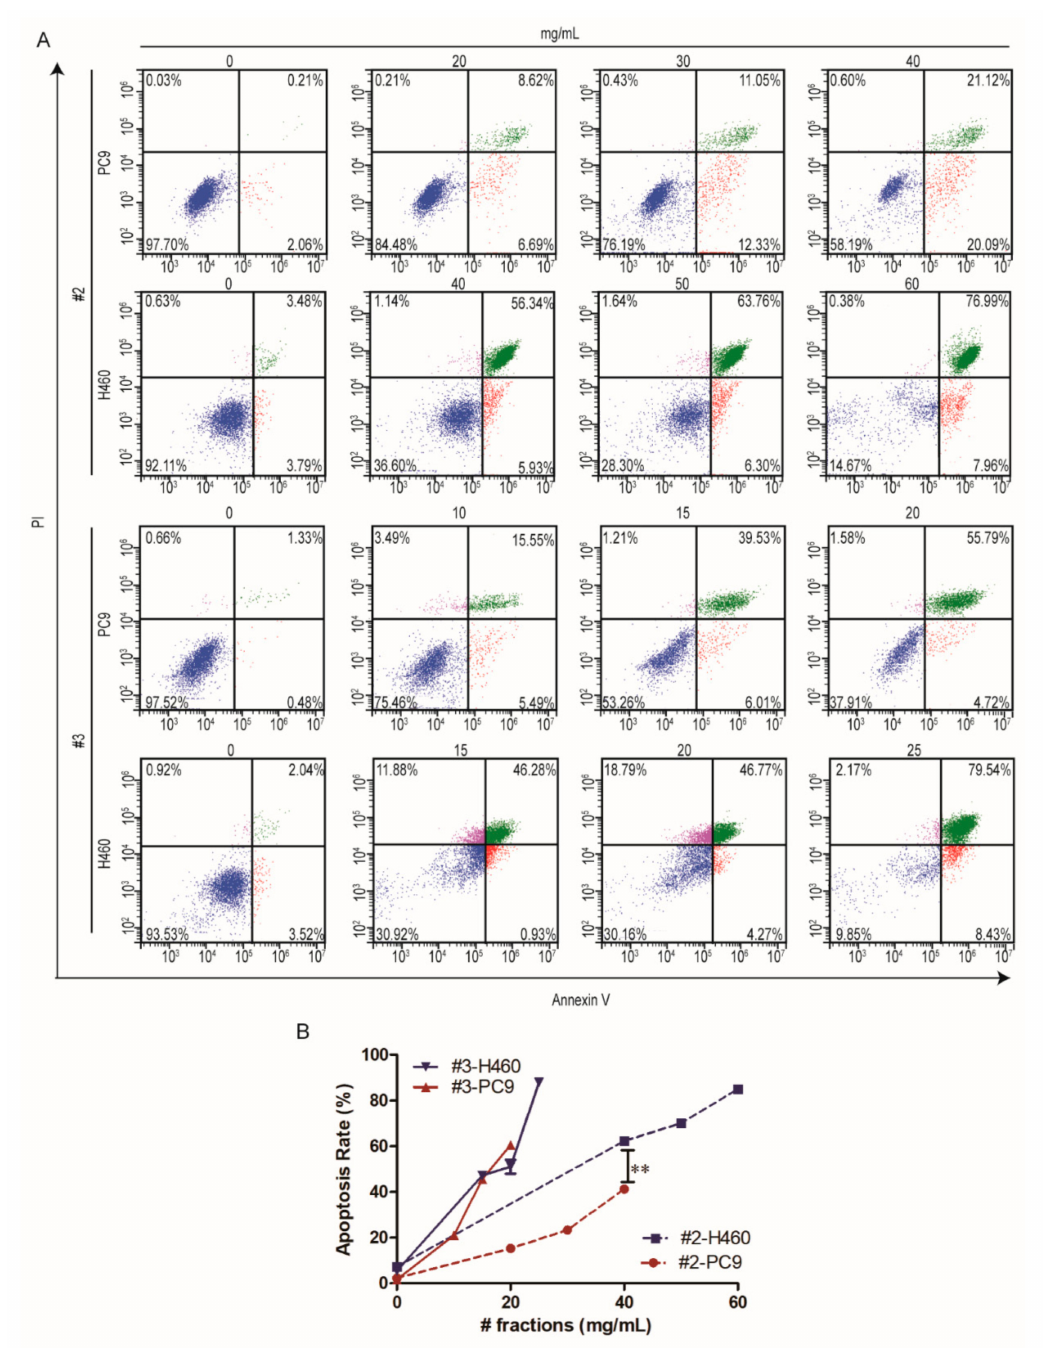
Figure 3. Apoptotic analysis of different fractions of F. luteovirens on PC9 and NCI-H460 cells at different concentrations. The induction of apoptosis was determined by flow cytometric analysis of Annexin V and PI-staining; the upper right quadrant (UR) represents late apoptotic cells stained with Annexin V and PI, and the lower right quadrant (LR) represents early apoptotic cells stained with Annexin V ( A ). The apoptosis rates were expressed as the mean ± SD of three independent replicates ( B ). **, p < 0.01, indicating extremely significant